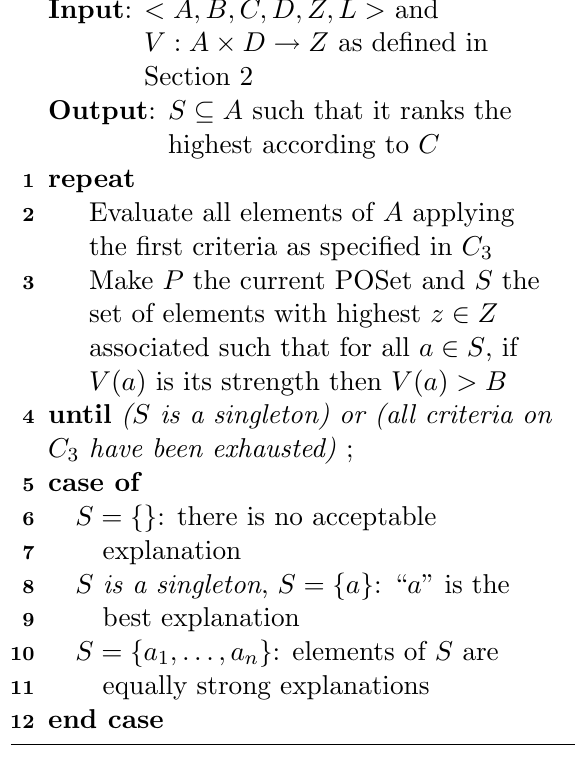
Fig. 6. Weigthing explanations with a hybrid